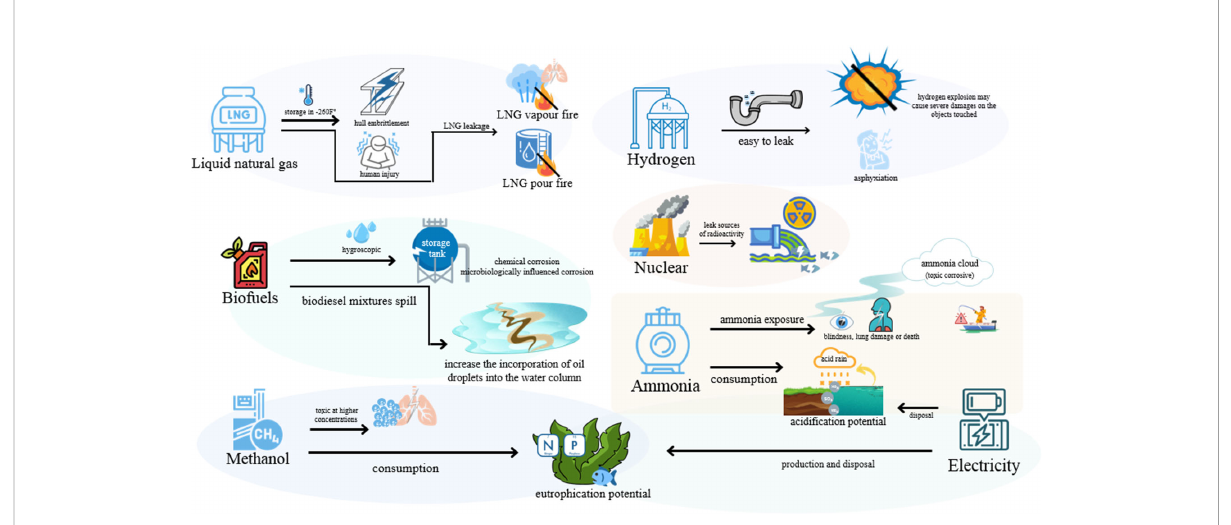
FIGURE 2 Special marine environmental risks posed by alternative-fuel-powered ships. Source: Authors ’